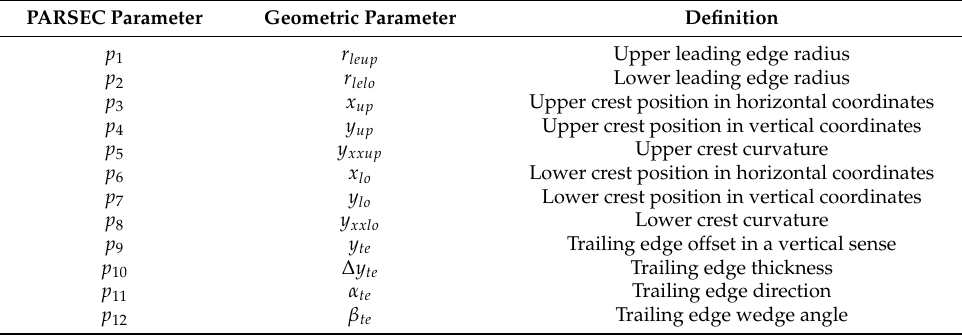
Figure 2. Parameter design variable of the airfoil for parameter section (PARSEC) parametrization. Table 1. The twelve basic airfoil for parameter section (PARSEC) parameters. PARSEC